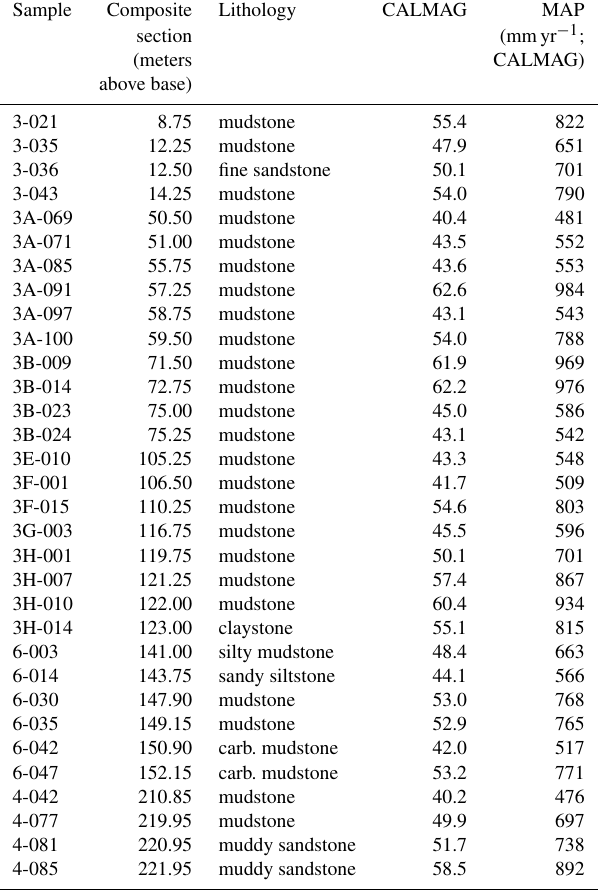
Table 3. Lithologic and CALMAG (see text for details) data, with interpreted mean annual precipitation (MAP) for White Pagoda Site samples. All samples listed here are derived from interpreted B hori- zons of